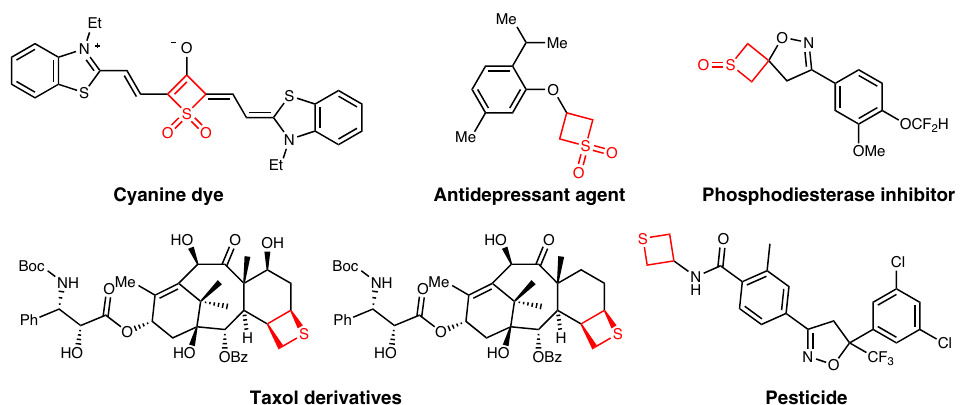
Fig. 2 Sulfur-containing four-membered ring in useful molecules. Some representative cases are listed.